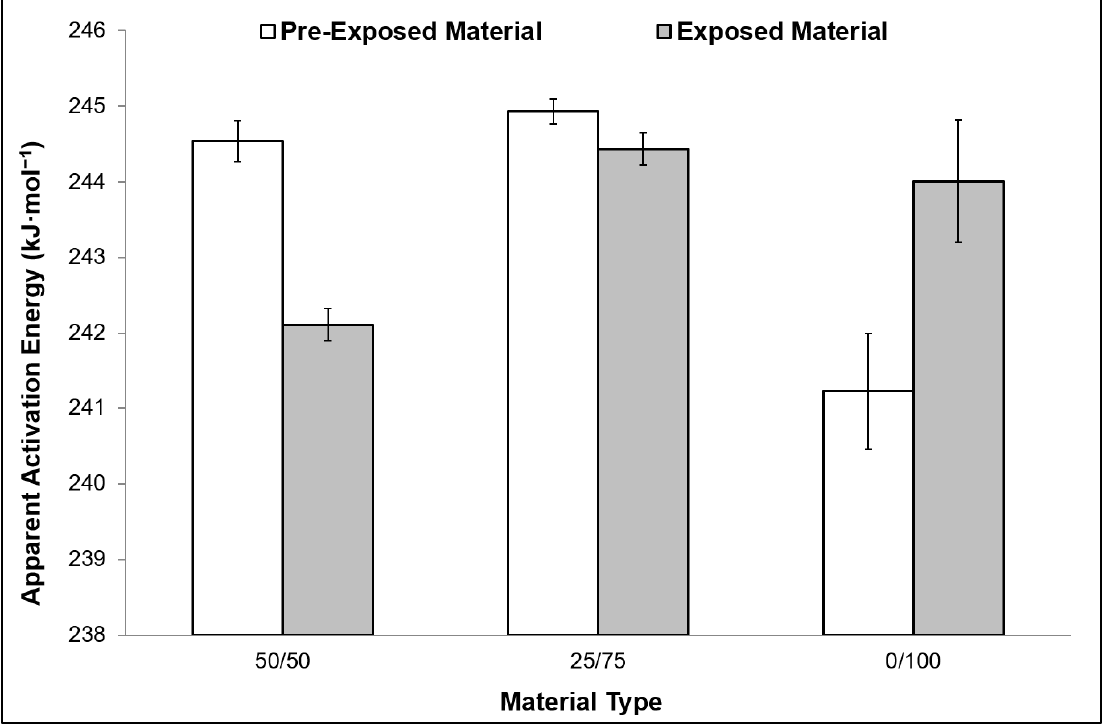
Figure 6. Variation in apparent activation energy between the pre-exposed and exposed materials determined using the OFW isoconversion method.